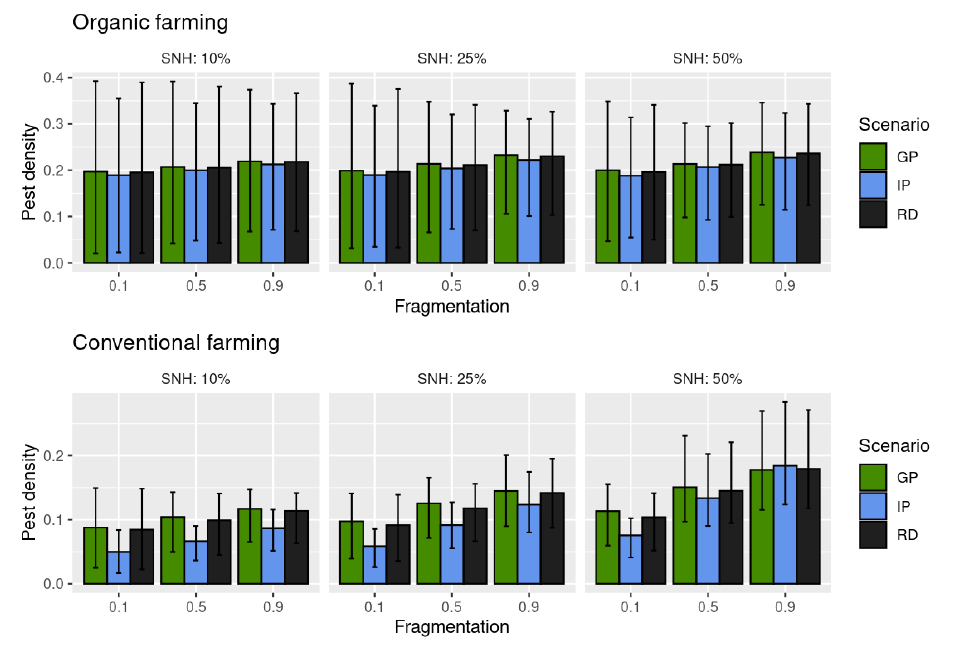
Figure 4 . Mean final (t=50) density of pests in organic (upper panel) and conventional (lower panel) fields as a function of the landscape context (fragmentation and percentage of semi-natural habitat). Results are presented for each OF spatial expansion scenario: GP (grouped plots), IP (isolated plots), RD